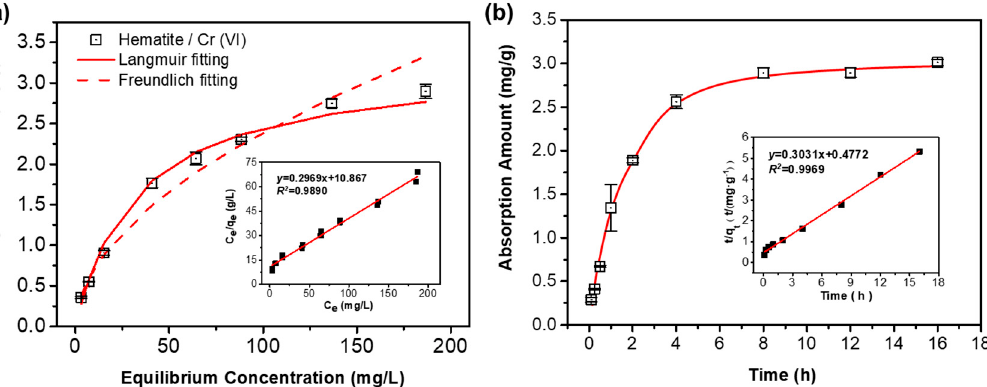
Figure 4. Cr (VI) adsorption by hematite. The data were fitted to the Freundlich (dashed line) and Langmuir (solid line) isotherm models. The insert is Langmuir adsorption isotherms ( a ); Kinetics of Cr (VI) adsorption by hematite fitted to the pseudo-second-order kinetics (solid line). The insert is the linear plot of the pseudo-second-order reaction ( b ).